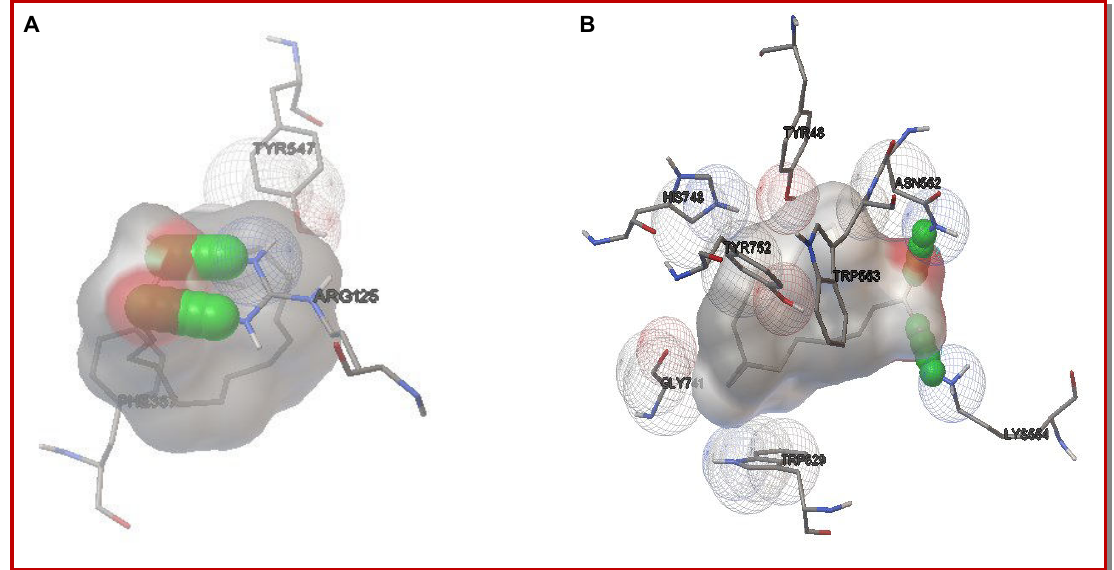
Figure 8: Inhibitory action of oleic acid with DPP-IV using AutoDoc hydrogen bond interaction A) A chain B) B